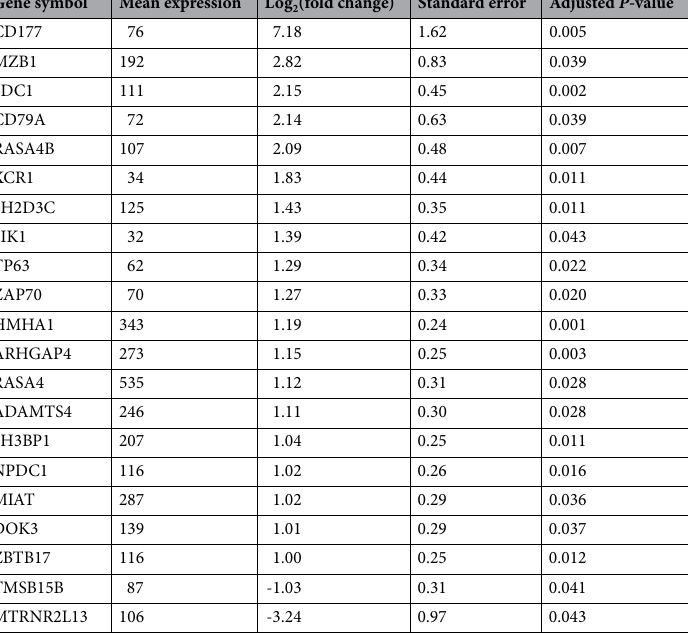
Table 2. Differentially expressed genes of